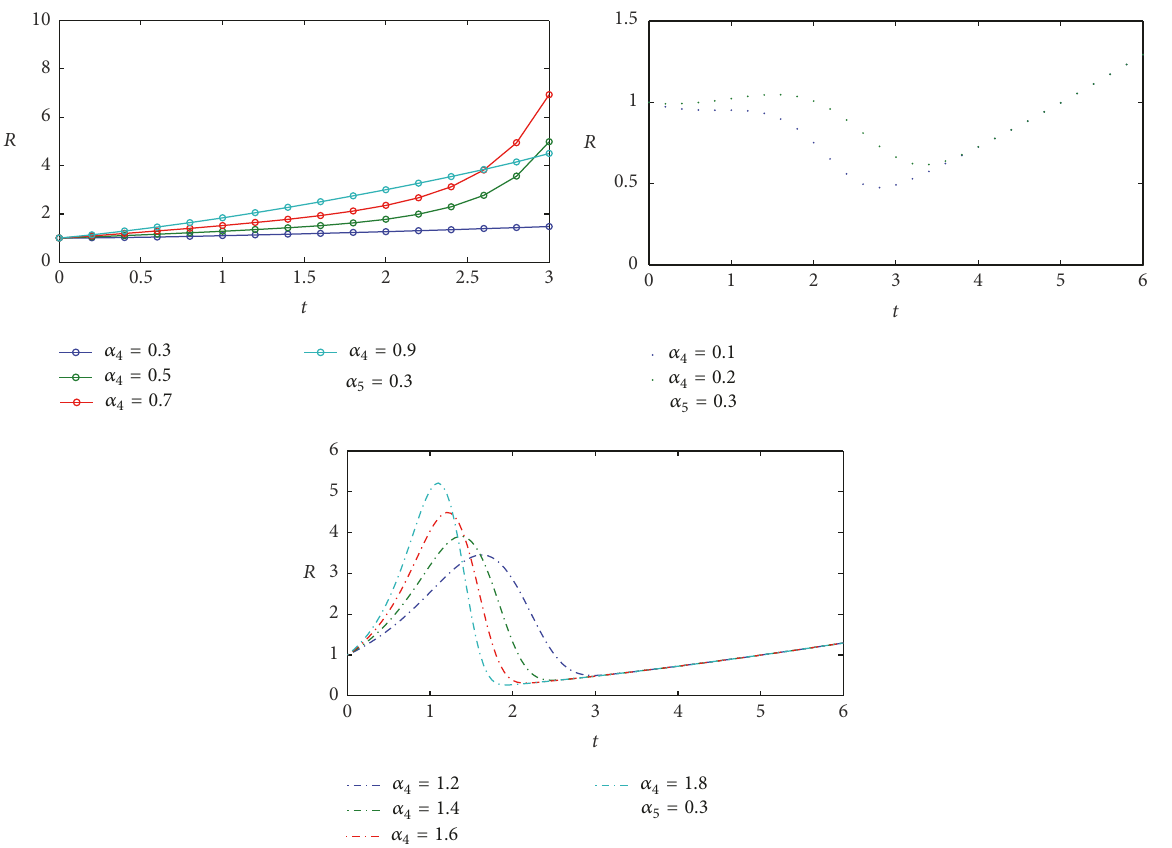
Figure 12: Variation of scale factor against time for fixed 𝛼 5 = 0.3 and different 𝛼 4